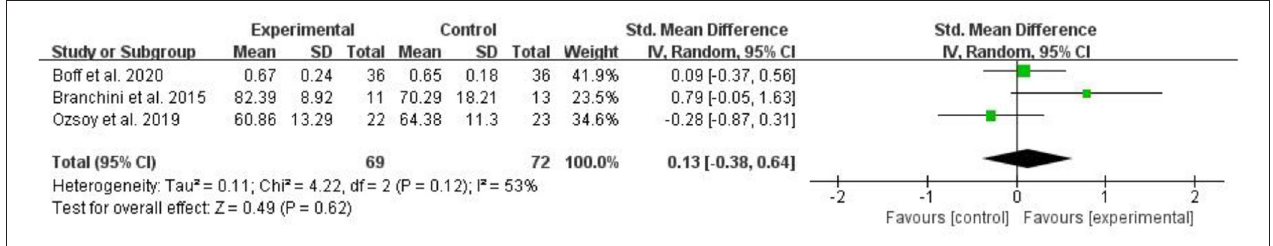
FIGURE 5 | Meta-analysis on quality of life.